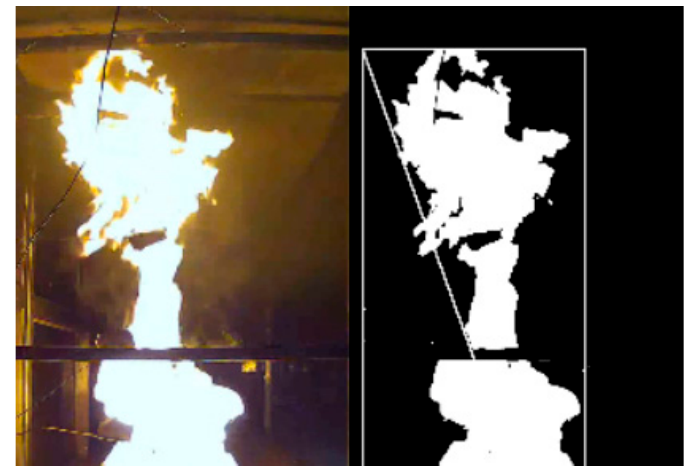
Figure 3. Processing method of flame image.